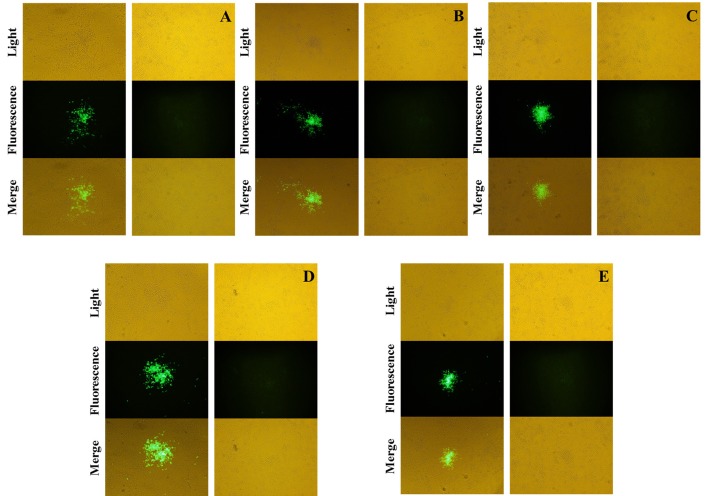
Screening and identification of mutants. The fused EGFP was expressed by the mutants rVVTT-C−EGFP+
(A), rVVTT-C−E−EGFP+
(B), rVVTT-C−E−A35−EGFP+
(C), rVVTT-C−E−A35−B−EGFP+
(D), and rVVTT-C−E−A35−B−A66−EGFP+ (MVTTEAB-EGFP+) (E) in BHK-21 cells. The virus-infected cells were identified by visualization of isolated fluorescent plaques in the same visual fields. Non-fluorescent plaques were observed for rVVTT-C−
(A), rVVTT-C−E−
(B), rVVTT-C−E−A35−
(C), rVVTT-C−E−A35−B−
(D), and rVVTT-C−E−A35−B−A66− (MVTTEAB) (E) mutants in BHK-21 cells (magnification 200×, A–E).